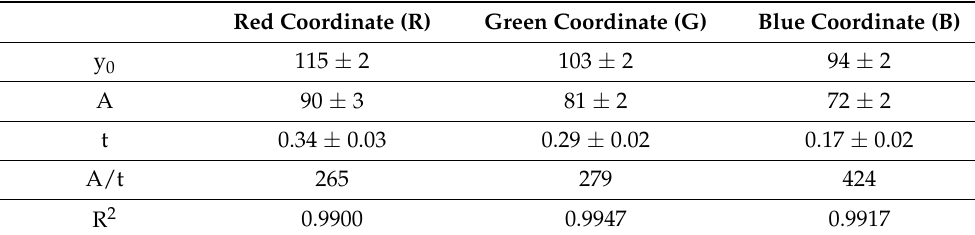
Table 1. Coefficients of exponential equations of color coordinates. Red Coordinate (R) Green Coordinate (G) Blue Coordinate (B) y 0 115 ± 2 103 ± 2 94 ± 2 A 90 ± 3 81 ± 2 72 ± 2 t 0.34 ± 0.03 0.29 ± 0.02 0.17 ± 0.02 A/t 265 279 424 R 2 0.9900 0.9947